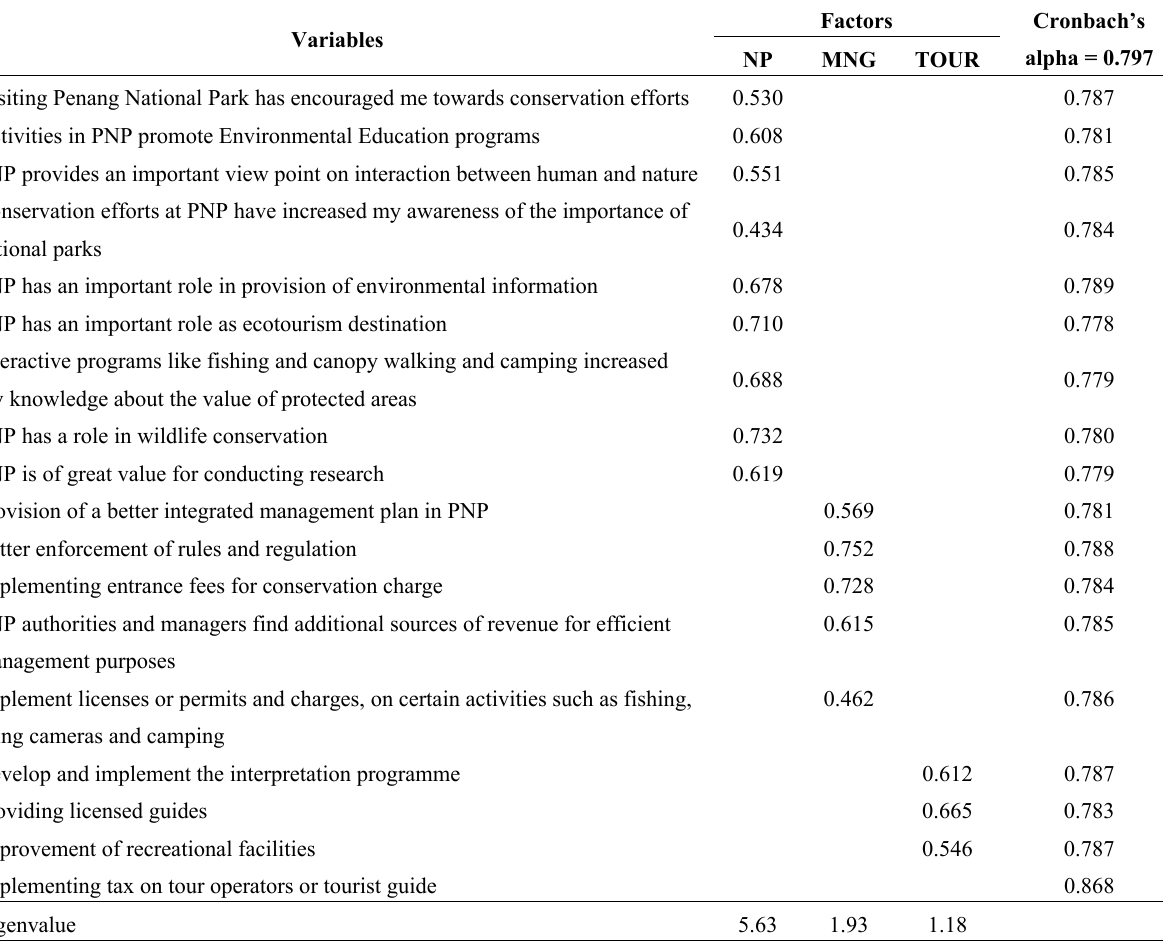
Table 4. Factor Structure of Visitor’s Perceptions on